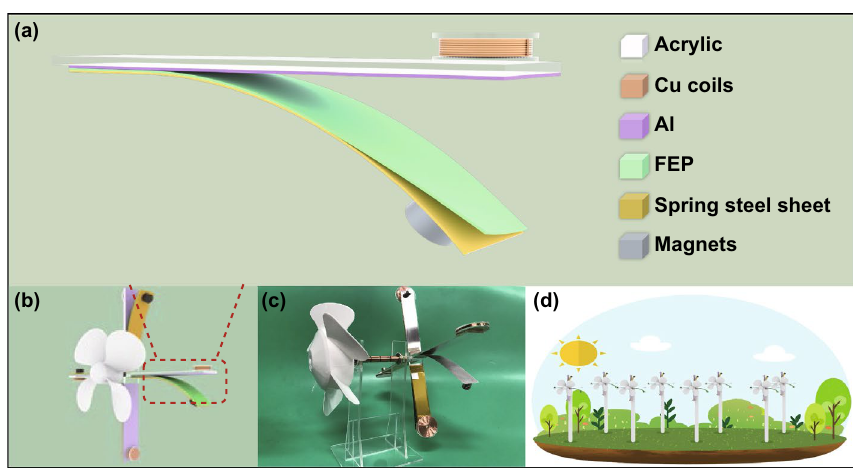
Fig. 1 Schematic illustration of the windmill-like hybrid nanogenerator (W-HNG). a Structural scheme of an individual unit of the W-HNG. b Schematic illustration of the whole W-HNG. c Photograph of the as-fabricated W-HNG. d Proposed network composed of numbers of W-GNGs for harvesting large-scale low-speed wind